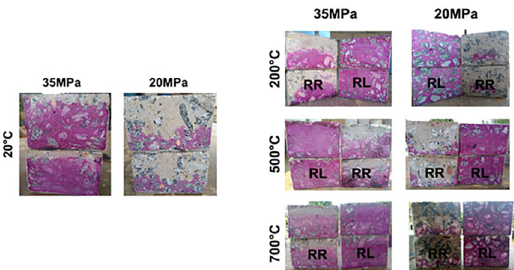
Figure 2. Carbonation advance front in the specimens.